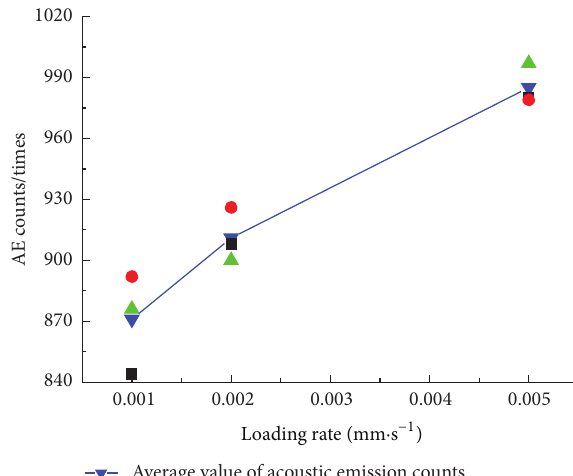
Figure 10: The relationship between acoustic emission counts and loading rate.